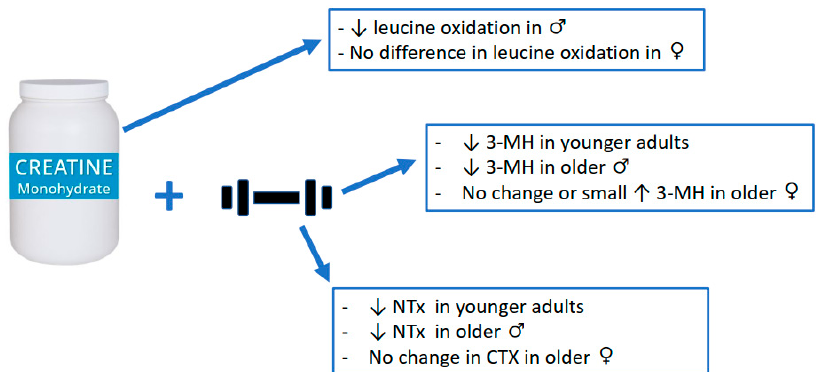
Figure 2. Anti-catabolic effects of creatine supplementation.